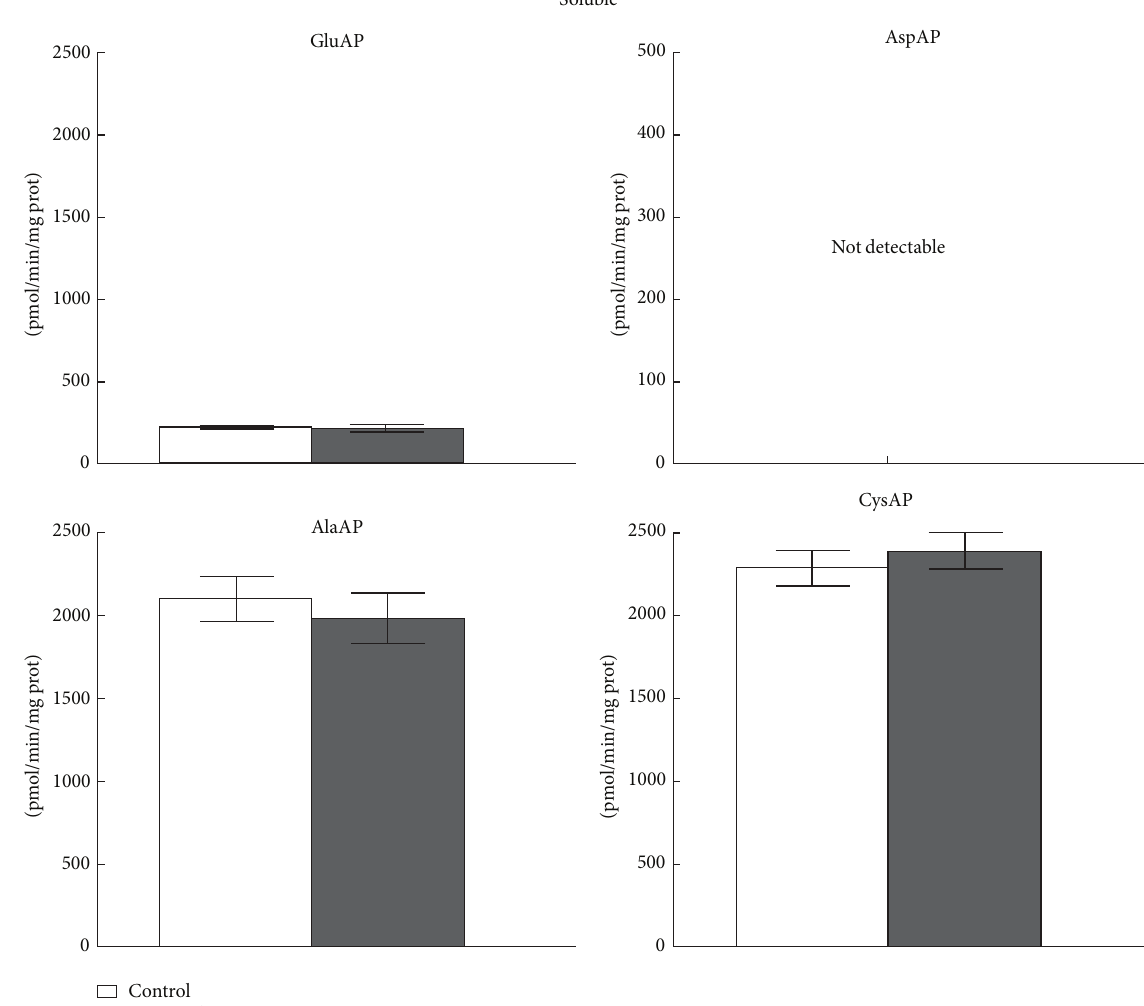
Figure 2: Soluble GluAP, AlaAP, and CysAP activities on the left ventricle of control ( 𝑛 = 10 ) and captopril-treated ( 𝑛 = 10 ) spontaneously hypertensive rats. The values represent the mean ± SEM of specific GluAP, AlaAP, and CysAP activities expressed as picomoles of glutamyl-, alanyl- or cystinyl- 𝛽 -naphthylamide hydrolyzed per min per mg of protein.